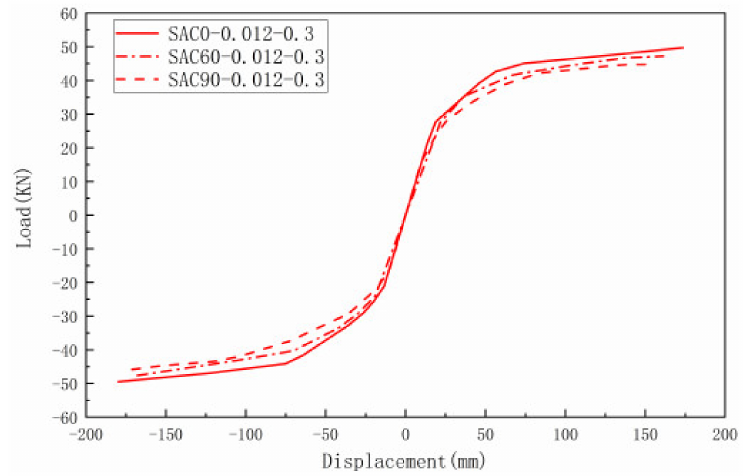
Figure 9. Skeleton curves of